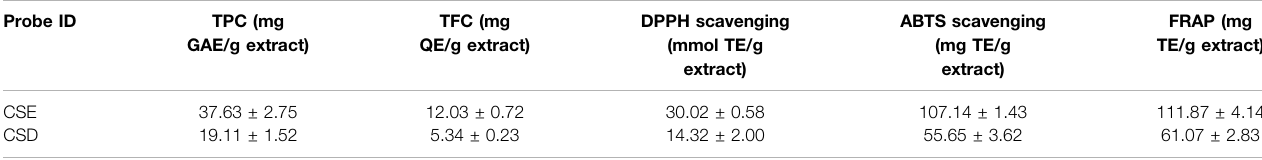
TABLE 1 | Total phenolic and fl avonoid content, DPPH and ABTS scavenging capacity, and ferric reducing ability of plasma (FRAP) of the extracts of CSE and CSD (values expressed are means ± S.D. of three parallel measurements, p < 0.05). Probe